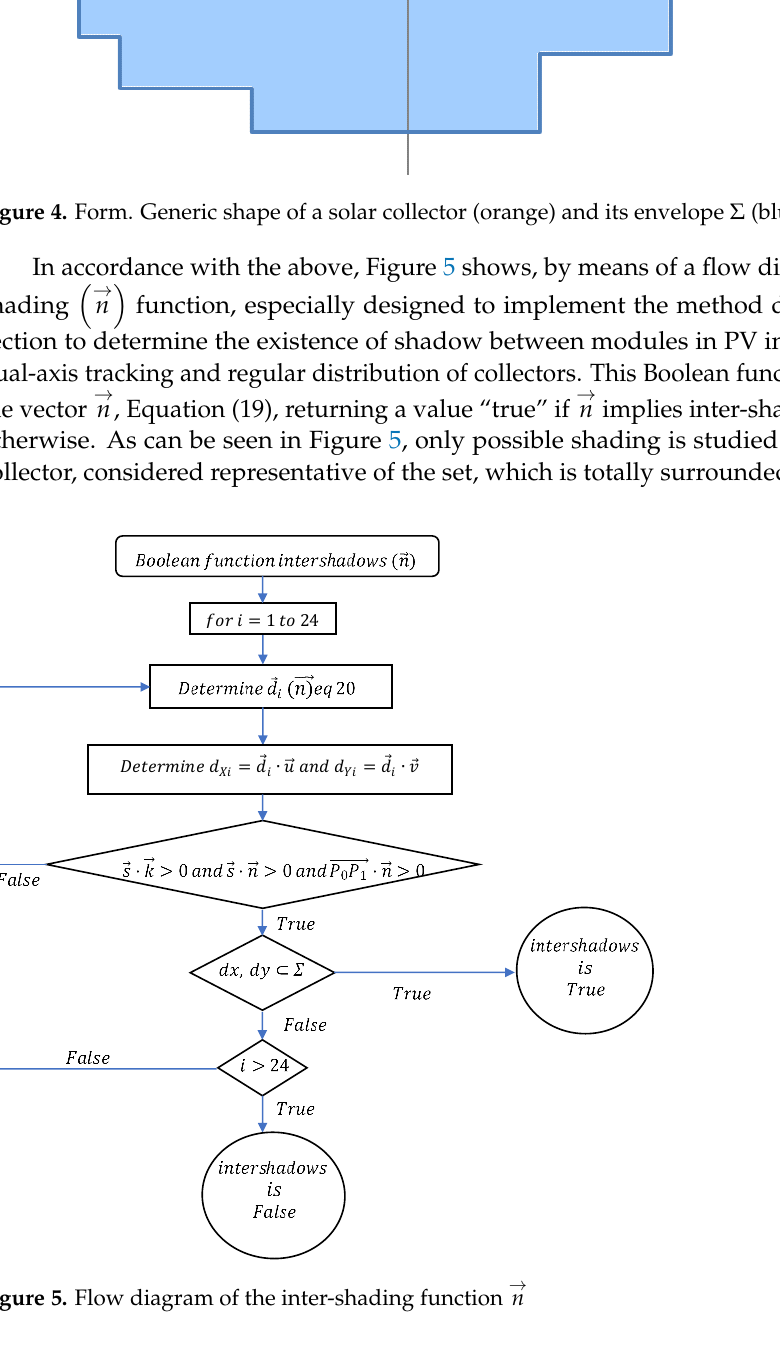
Figure 5. Flow diagram of the inter-shading function (n⃗⃗).